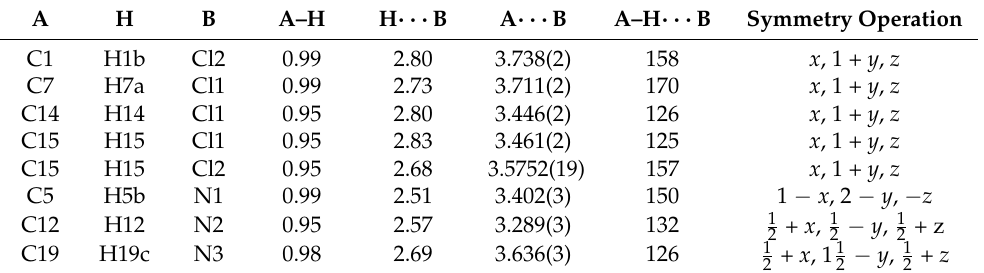
Figure 2. The molecular packing in the crystal of 1 : a view of the unit cell contents shown in projection down the b -axis. The intra-layer C–H · · · Cl and C–H · · · N contacts are indicated by orange and blue dashed lines, respectively, whereas the inter-layer C–H · · · N contacts are shown as purple dashed lines. Table 1. Geometric parameters (Å, ◦ ) characterising the non-covalent (A–H · · · B) interactions present in the crystal of 1